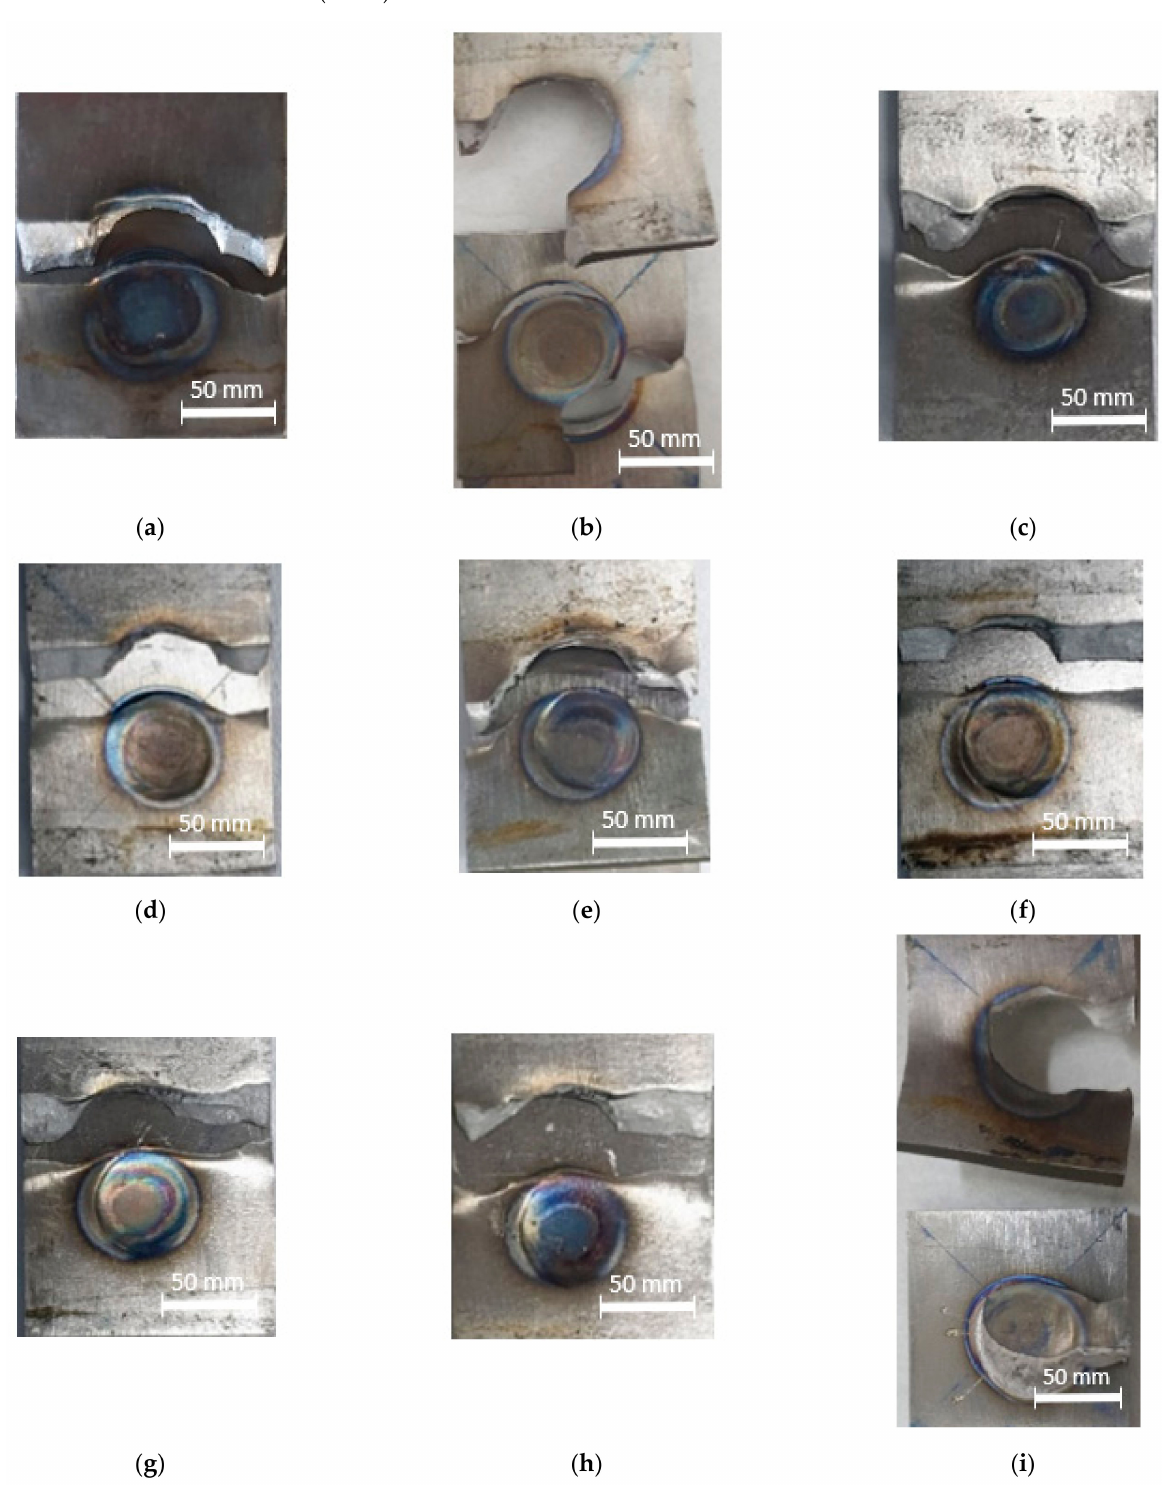
Figure 10. Weld nuggets failure modes at RSW parameters: ( a ) 8 kA, 28 cycles, and 3 kN; ( b ) 8 kA, 30 cycles, and 4 kN; ( c ) 8 kA, 32 cycles, and 5 kN; ( d ) 9 kA, 28 cycles, and 4 kN; ( e ) 9 kA, 30 cycles, and 5 kN; ( f ) 9 kA, 32 cycles, and 3 kN; ( g ) 10 kA, 28 cycles, and 5 kN; ( h ) 10 kA, 30 cycles, and 3 kN; ( i ) 10 kA, 32 cycles, and 4